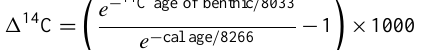
Fig. 1. Map showing the locations of core MD01-2420 (yellow star) and cores used in previous ventilation studies (red circles) in the western North Pacific. The map was drawn using Ocean Data View